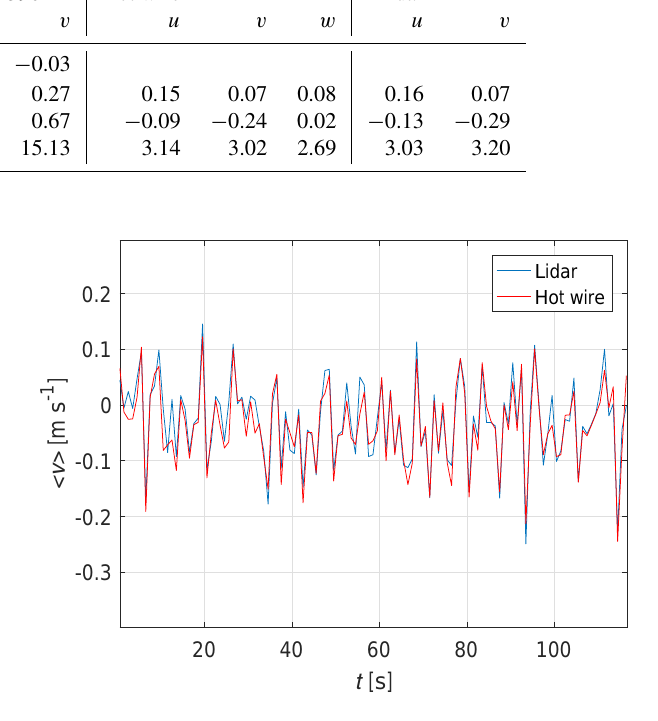
Figure 15. Visual comparison of the 1Hz averaged v component.